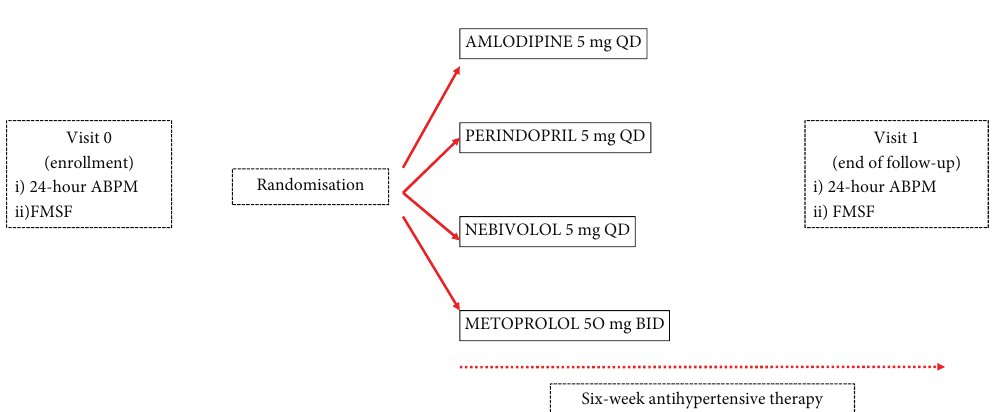
Figure 1: The study protocol. Patients with untreated hypertension were randomised to one of the open-label antihypertensive treatment modes and were prescribed either amlodipine 5mg once a day (QD) or perindopril 5mg QD, or nebivolol 5mg QD or metoprolol 50mg twice a day (BID). Measurements of the 24-hour ambulatory blood pressure monitoring (ABPM) and the flow-mediated 460nm skin fluorescence (FMSF) were made at visit 1 before starting the prescribed treatment and at visit 2 after the six-week therapy. Patients were asked to take their morning dose of the prescribed medication on the day of visit